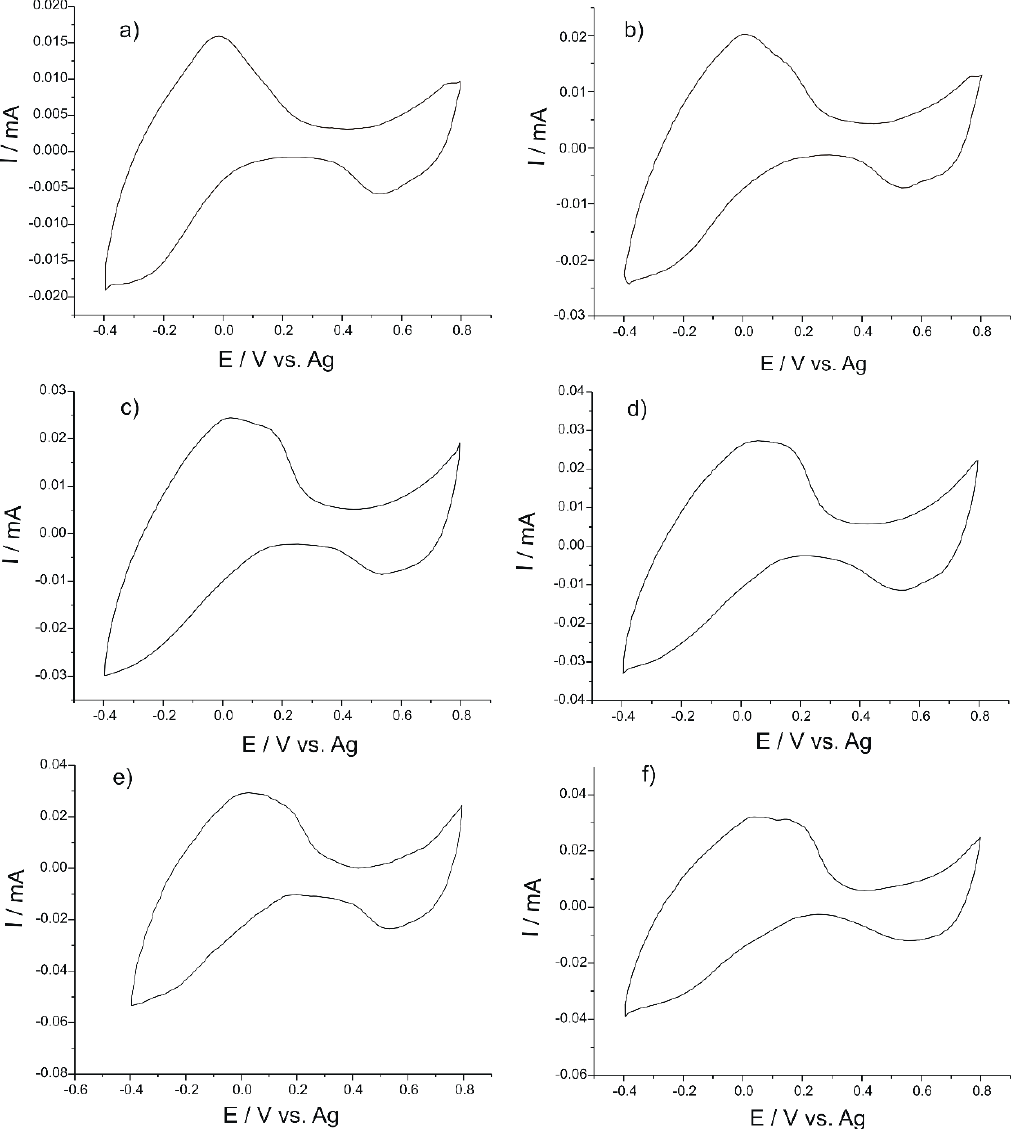
Figure 2. The voltammetric responses of the PB-SPE sensor exposed to all water samples ( a ) PD; ( b ) DS; ( c ) CP; ( d ) DP; ( e ) GR; (f) LN.